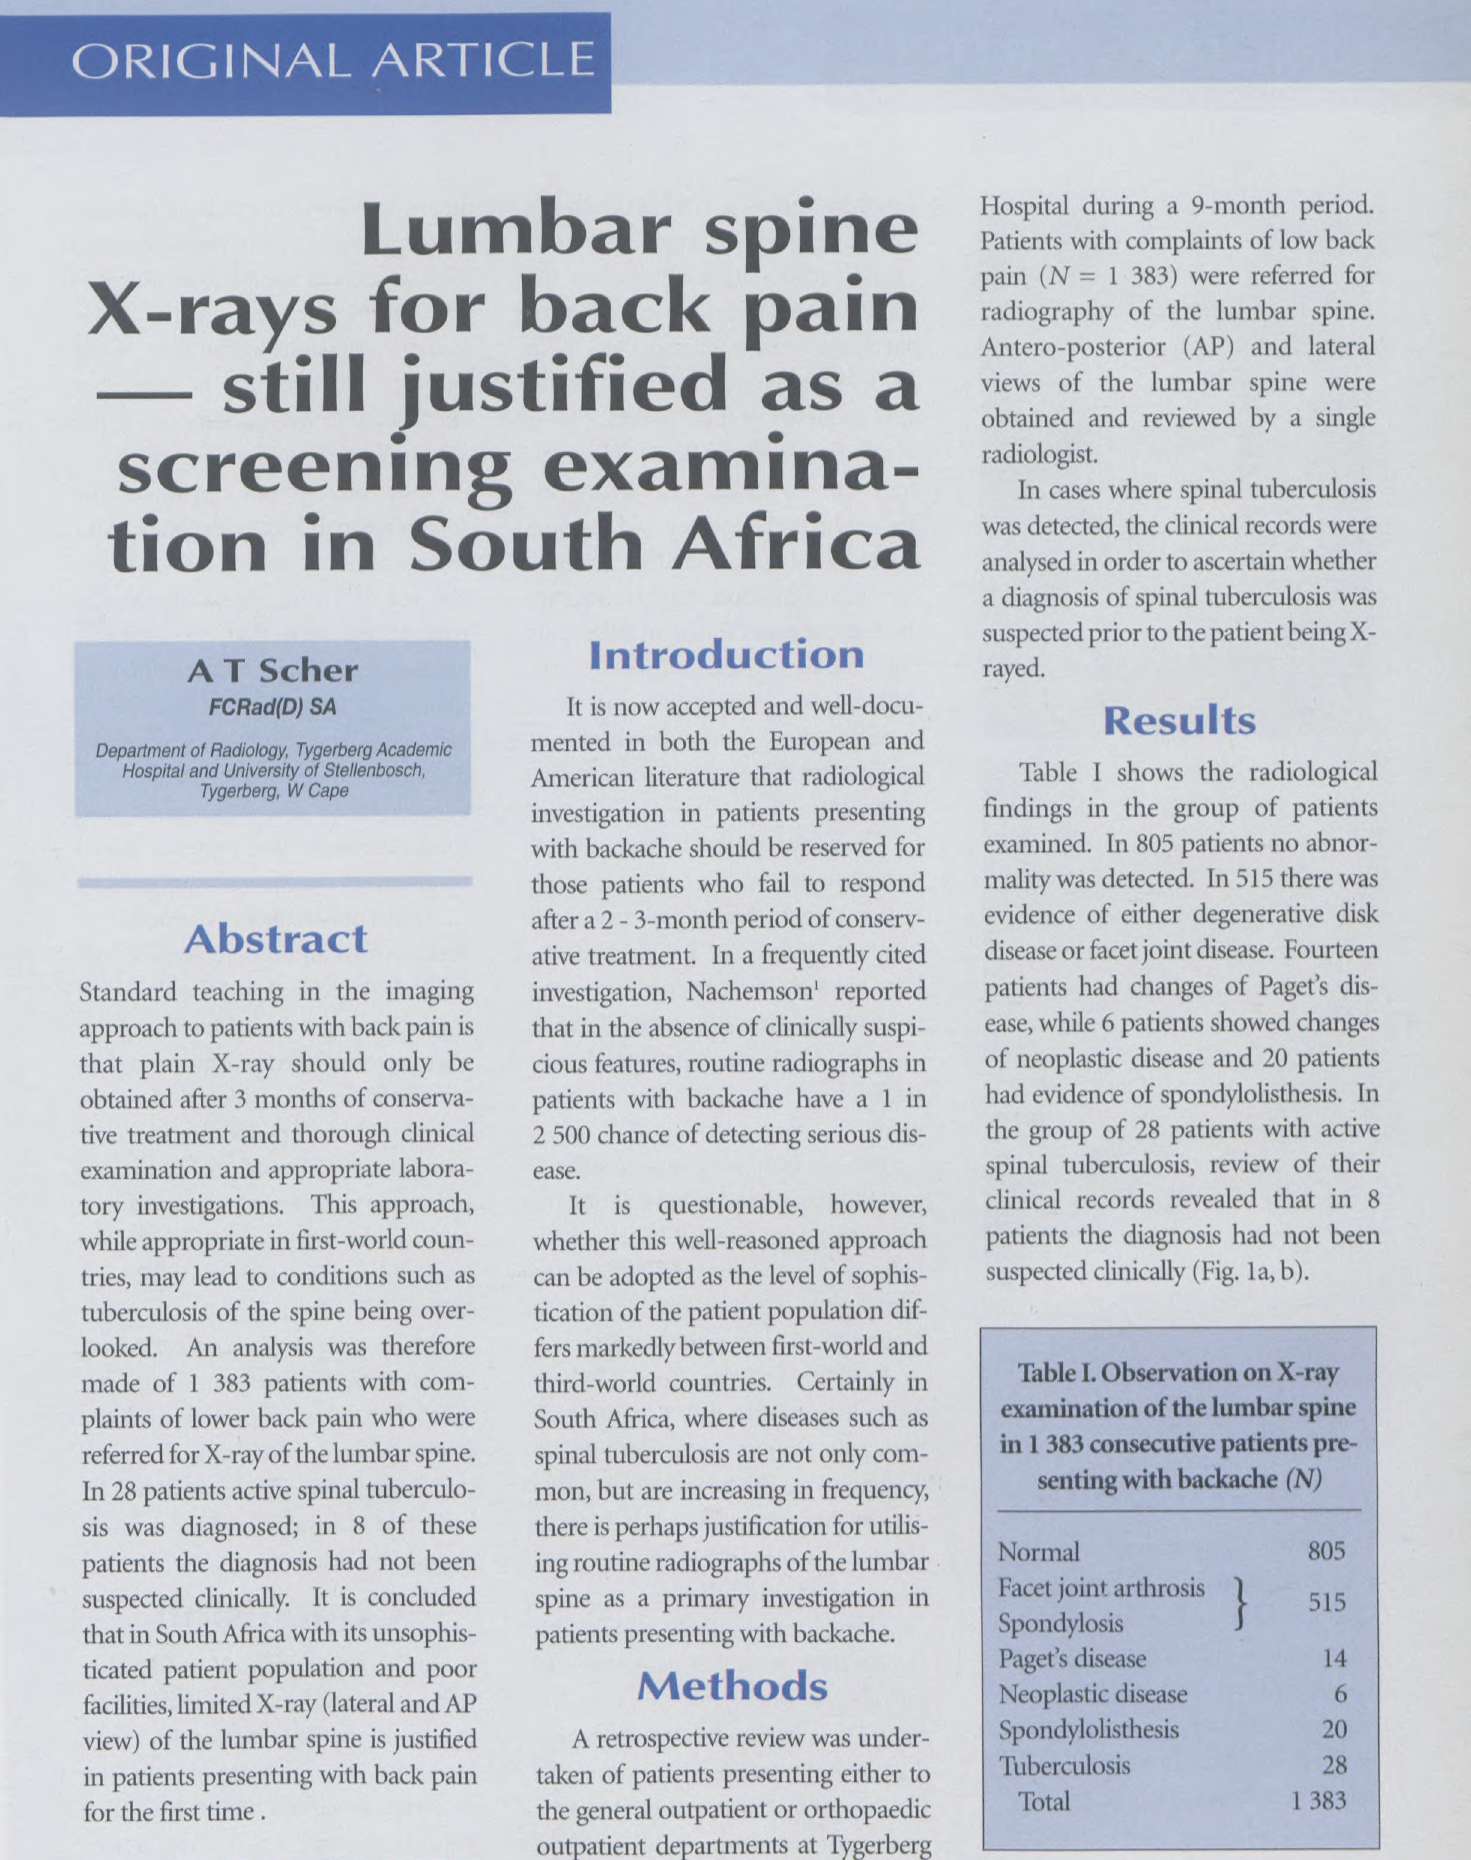
Table I. Observation on